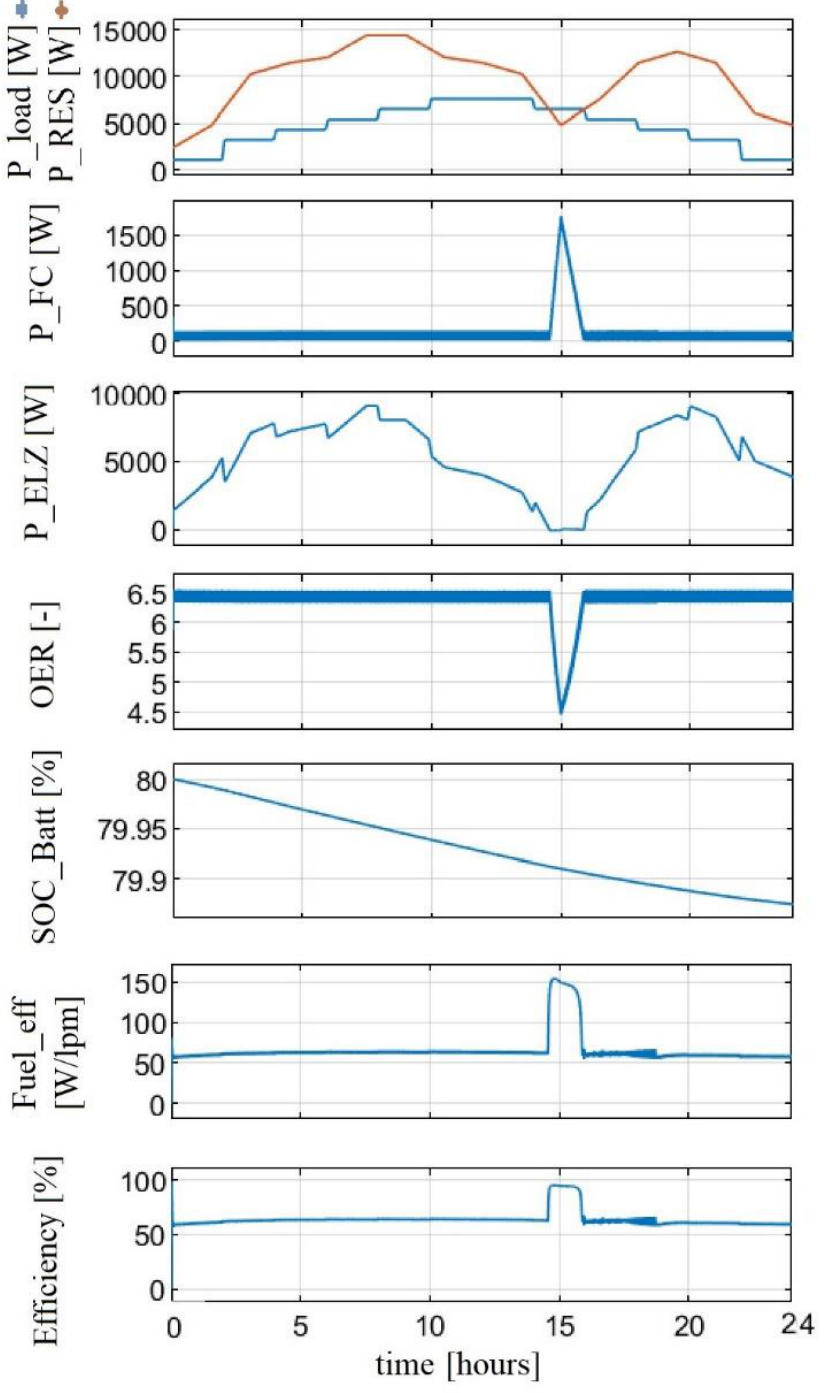
Figure 5. Operation of the charging station based on the FC/ELZ/RES DCmG when p RES > p Load .